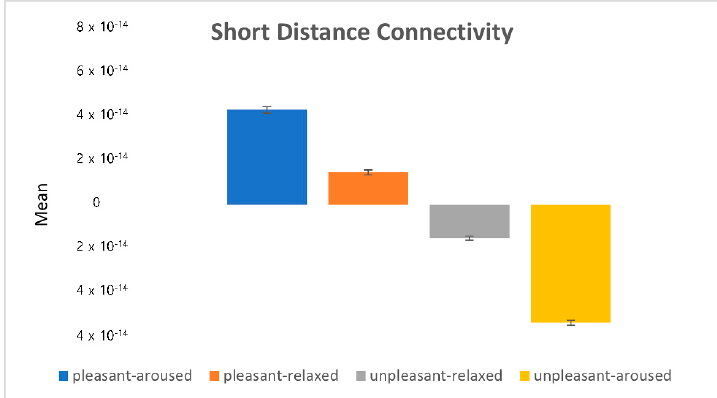
Figure 19. The eigenvalues in the short-distance connectivity.